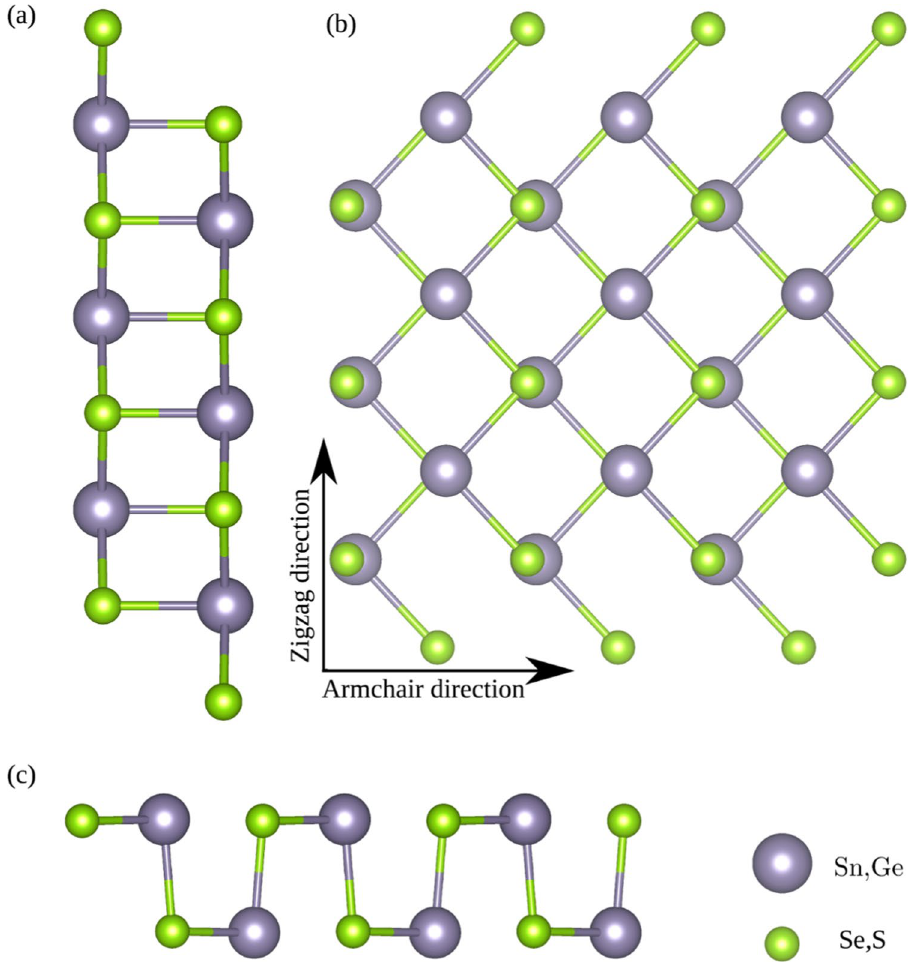
Figure 1. Crystal structure of two-dimensional monochalcogenides SnSe, SnS, GeSe, and GeS. ( a ) Side view perpendicular to the zigzag direction, ( b ) top view, ( c ) side view perpendicular to the armchair direction.